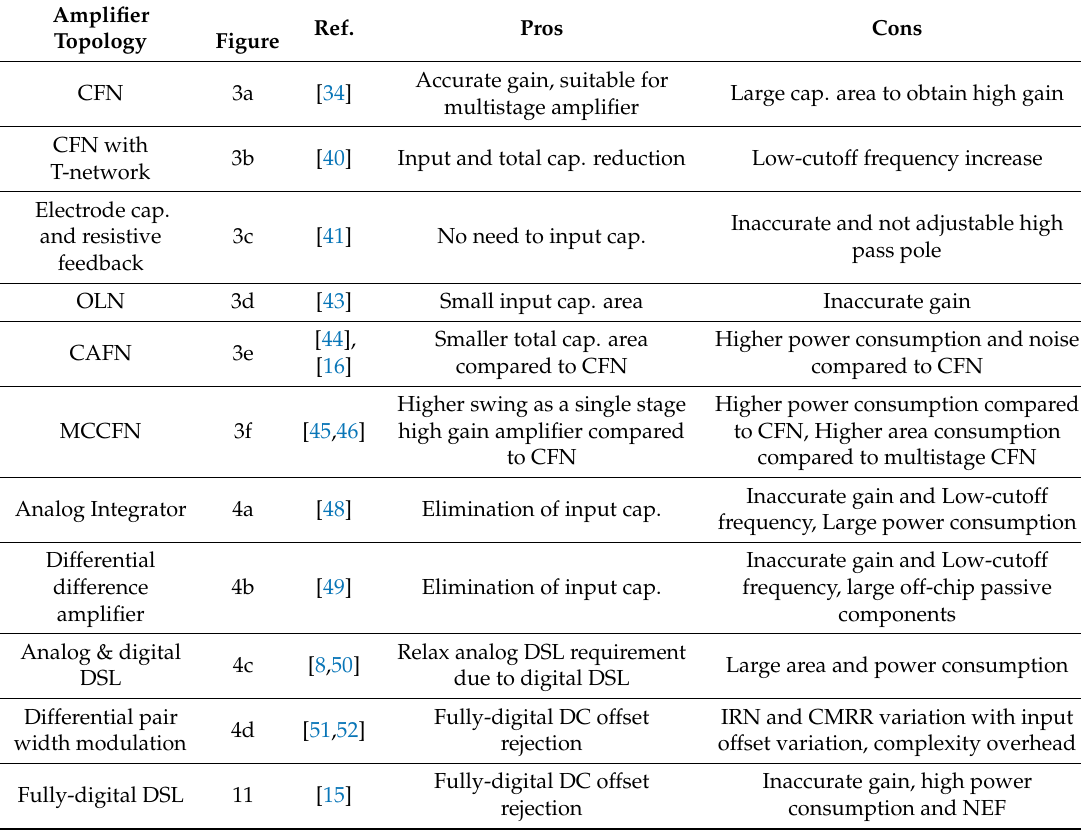
Table 2. Comparison between different topologies of neural